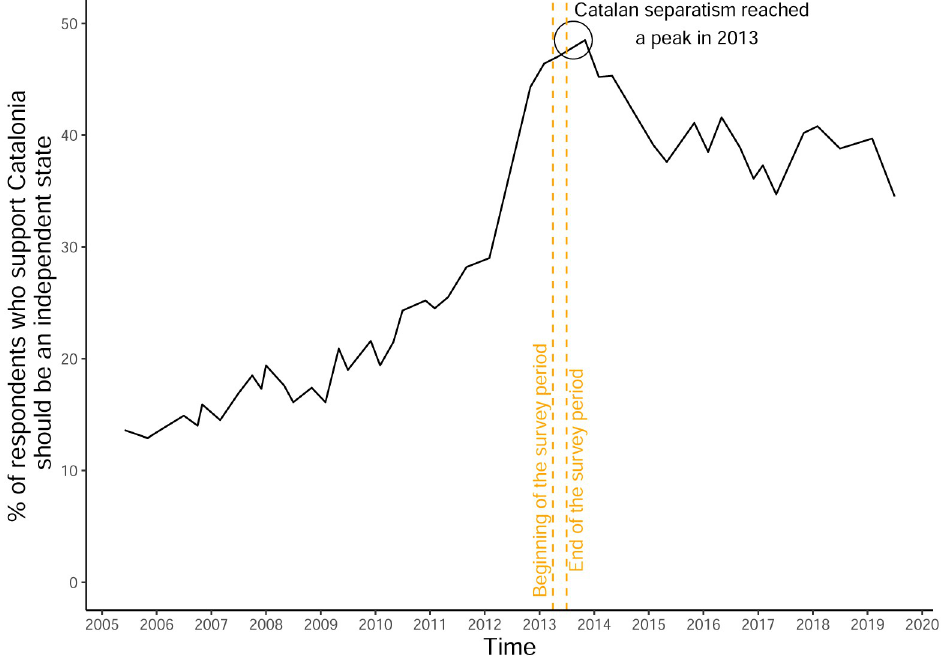
Fig 1. Evolution of the support for Catalan independence (2006–2019). The question from the Centre d’Estudis d’Opinió (CEO) used to create the figure has the following wording: “Which kind of political entity should Catalonia be with respect to Spain? Independent state/ Federal state within Spain/Autonomous community within Spain/Region within Spain.” This question is used—rather than the direct question on whether respondents support independence or not—because it has been asked for a longer time span by the CEO.